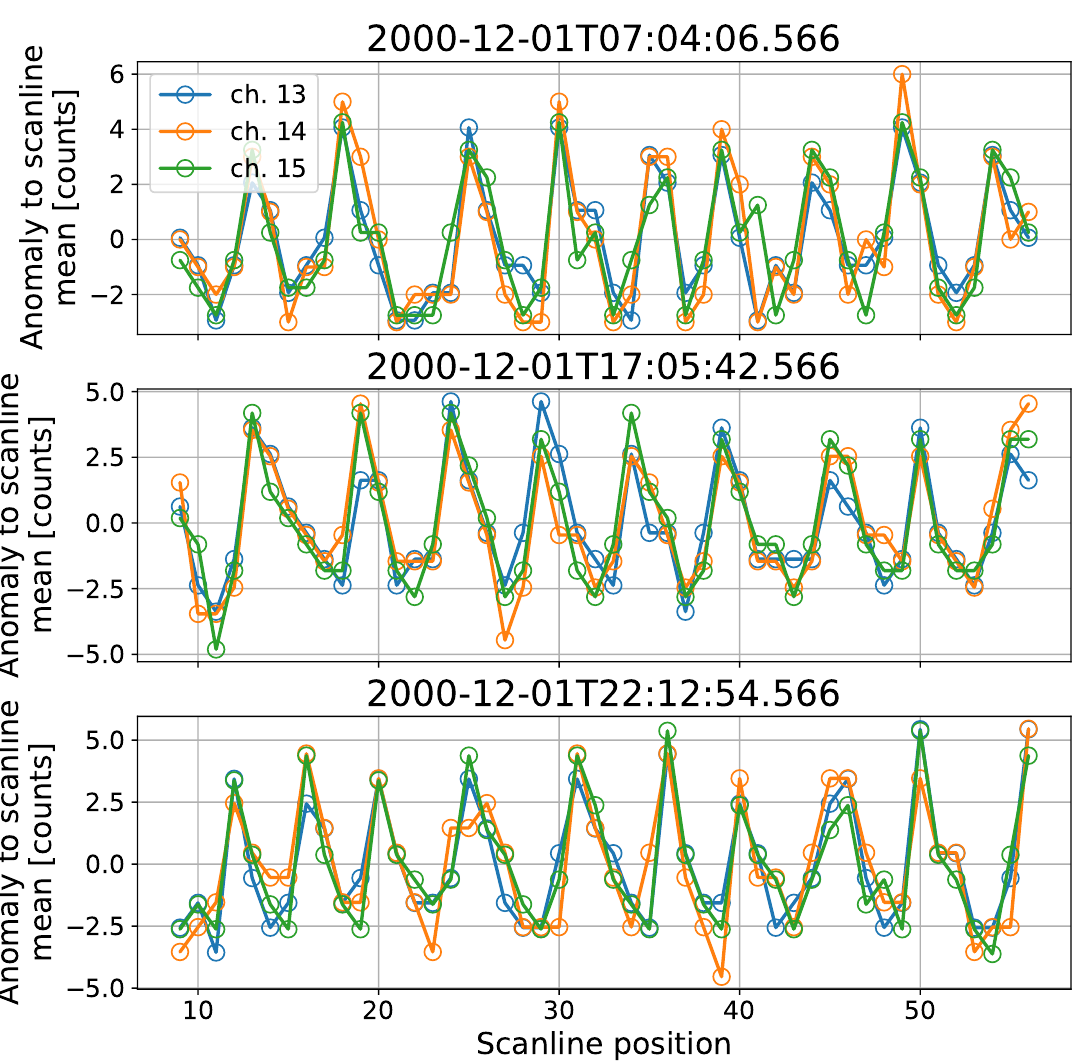
Figure 2. Like Figure 1, but showing three examples for channels 13–15 on